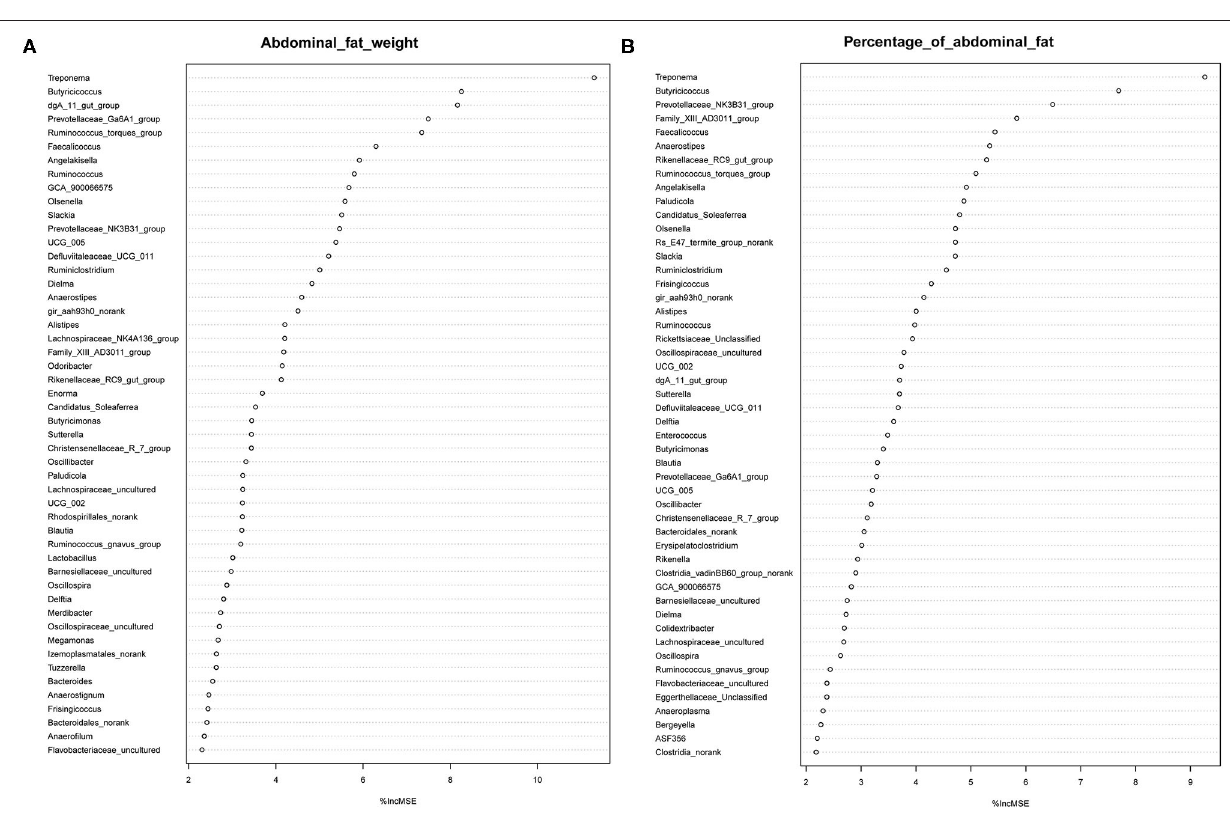
Frontiers in Veterinary Science |